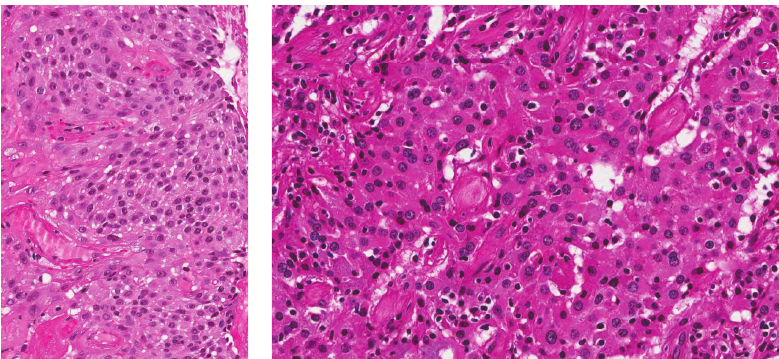
Figure 5: Histopathology shows a polyp lined with malignant squamous epithelium consistent with the diagnosis of well-differentiated squamous cell